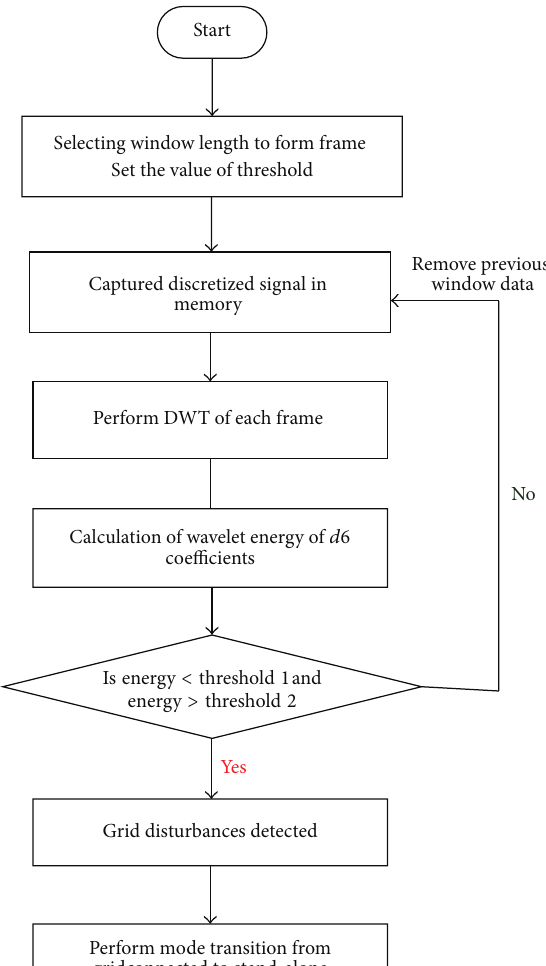
Figure 6: Flowchart for detection of grid